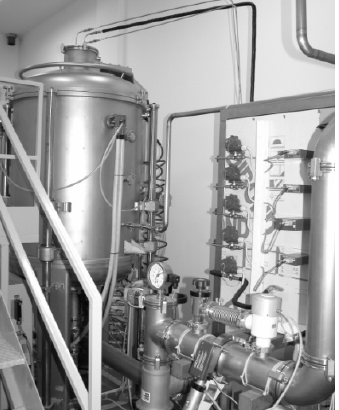
Figure 1: CVI/CVD plant.